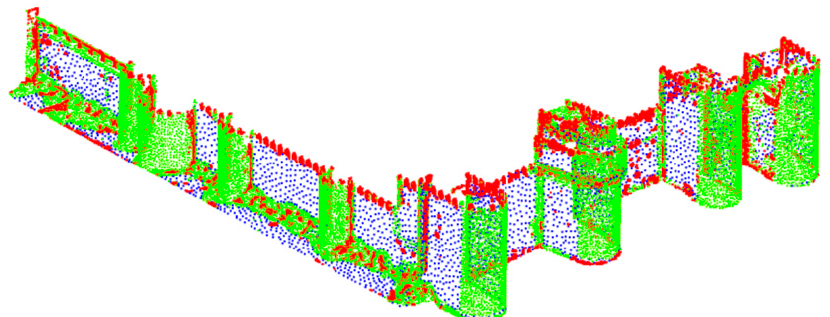
Figure 11. Final MLS point cloud optimization and simplification: (i) planar or low curvature in blue; (ii) cylindrical, mild transitions and medium curvature in green; and (iii) the abrupt transitions of high curvature in red.